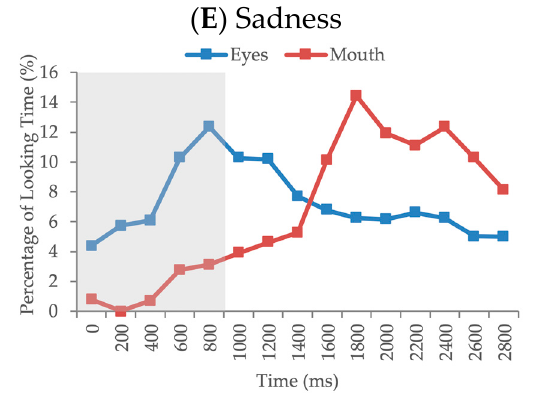
Figure 3. Time-course analysis: percentage of looking time to the eyes and the mouth over the first 3000 ms of the trial presented for ( A ) Angry; ( B ) Fearful; ( C ) Happy; ( D ) Neutral; and ( E ) Sad faces ( n = 63). Time intervals with significant differences are highlighted in the grey boxes ( p s < 0.016; adjusted p s < 0.049).